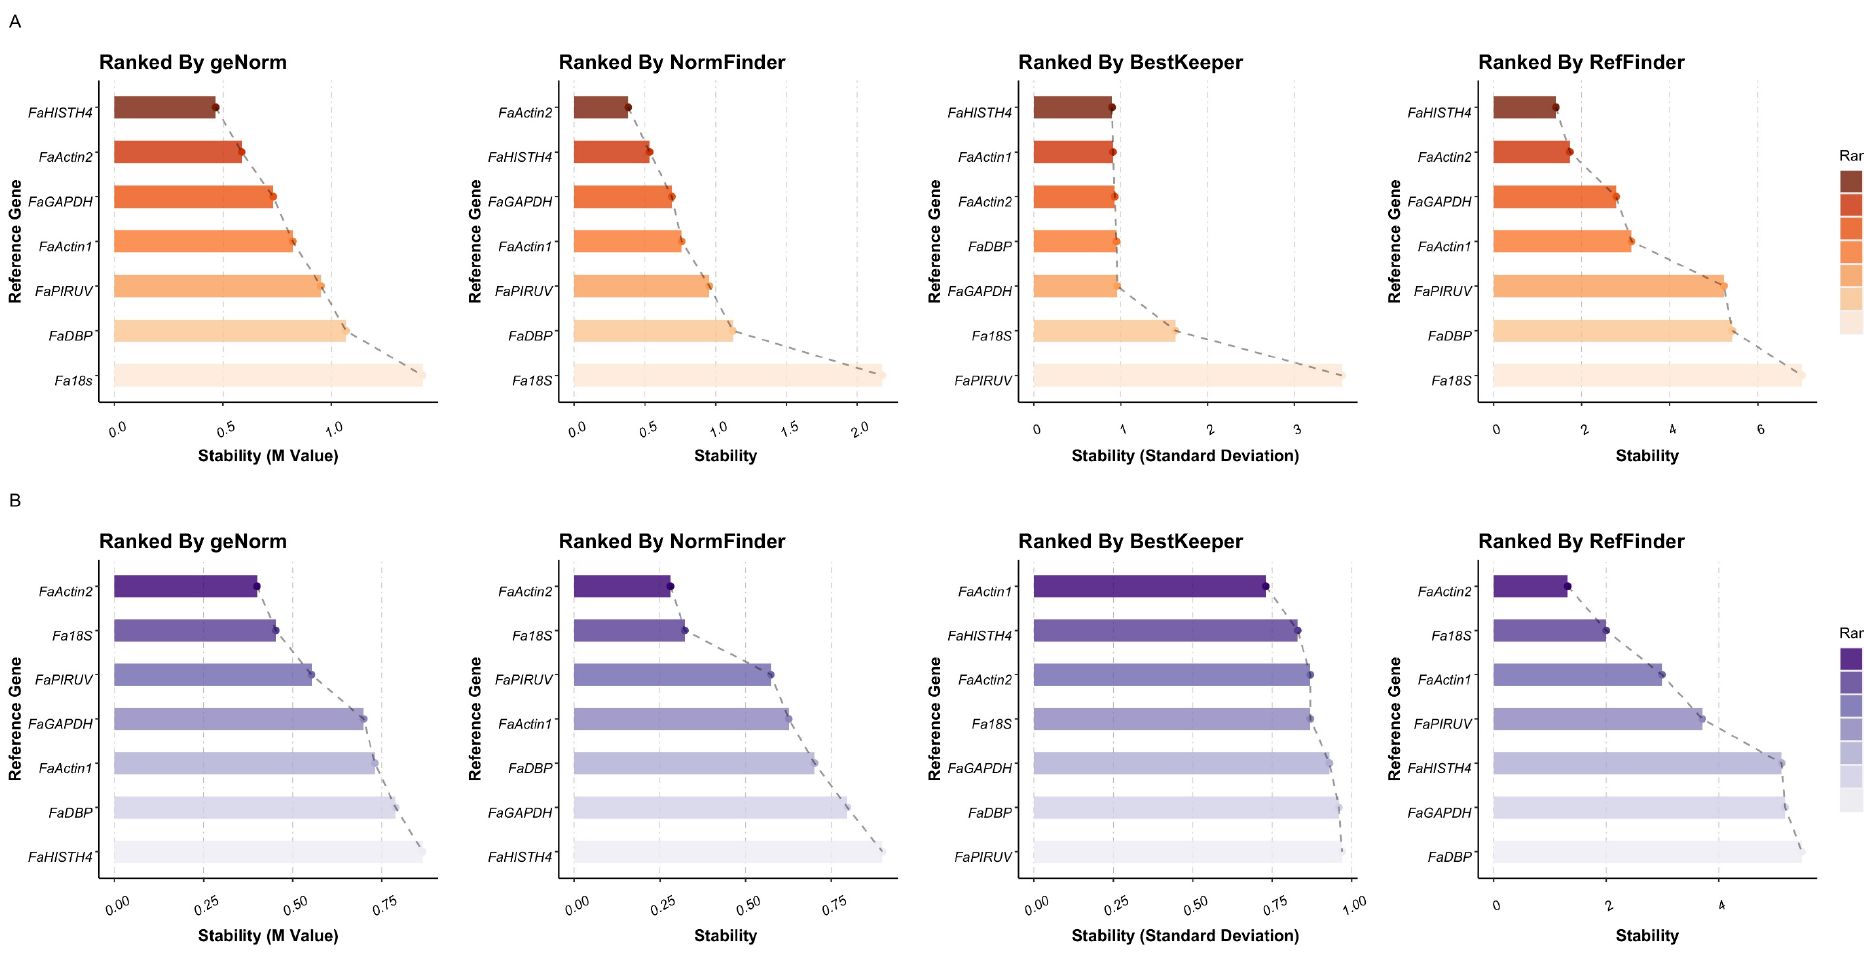
Figure 2. Expression stability ranks of the candidate reference genes under heat stress ( A ) and cold stress ( B